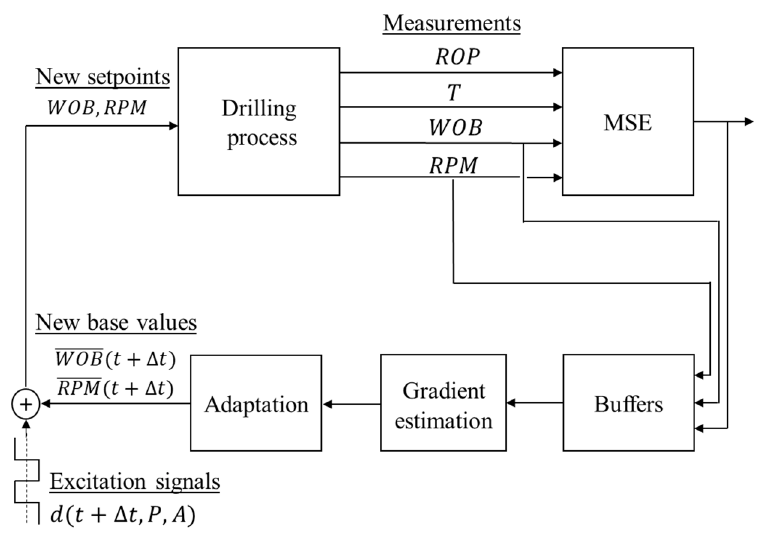
Figure 9. Block diagram of multivariable extremum seeking applied to minimize the MSE .